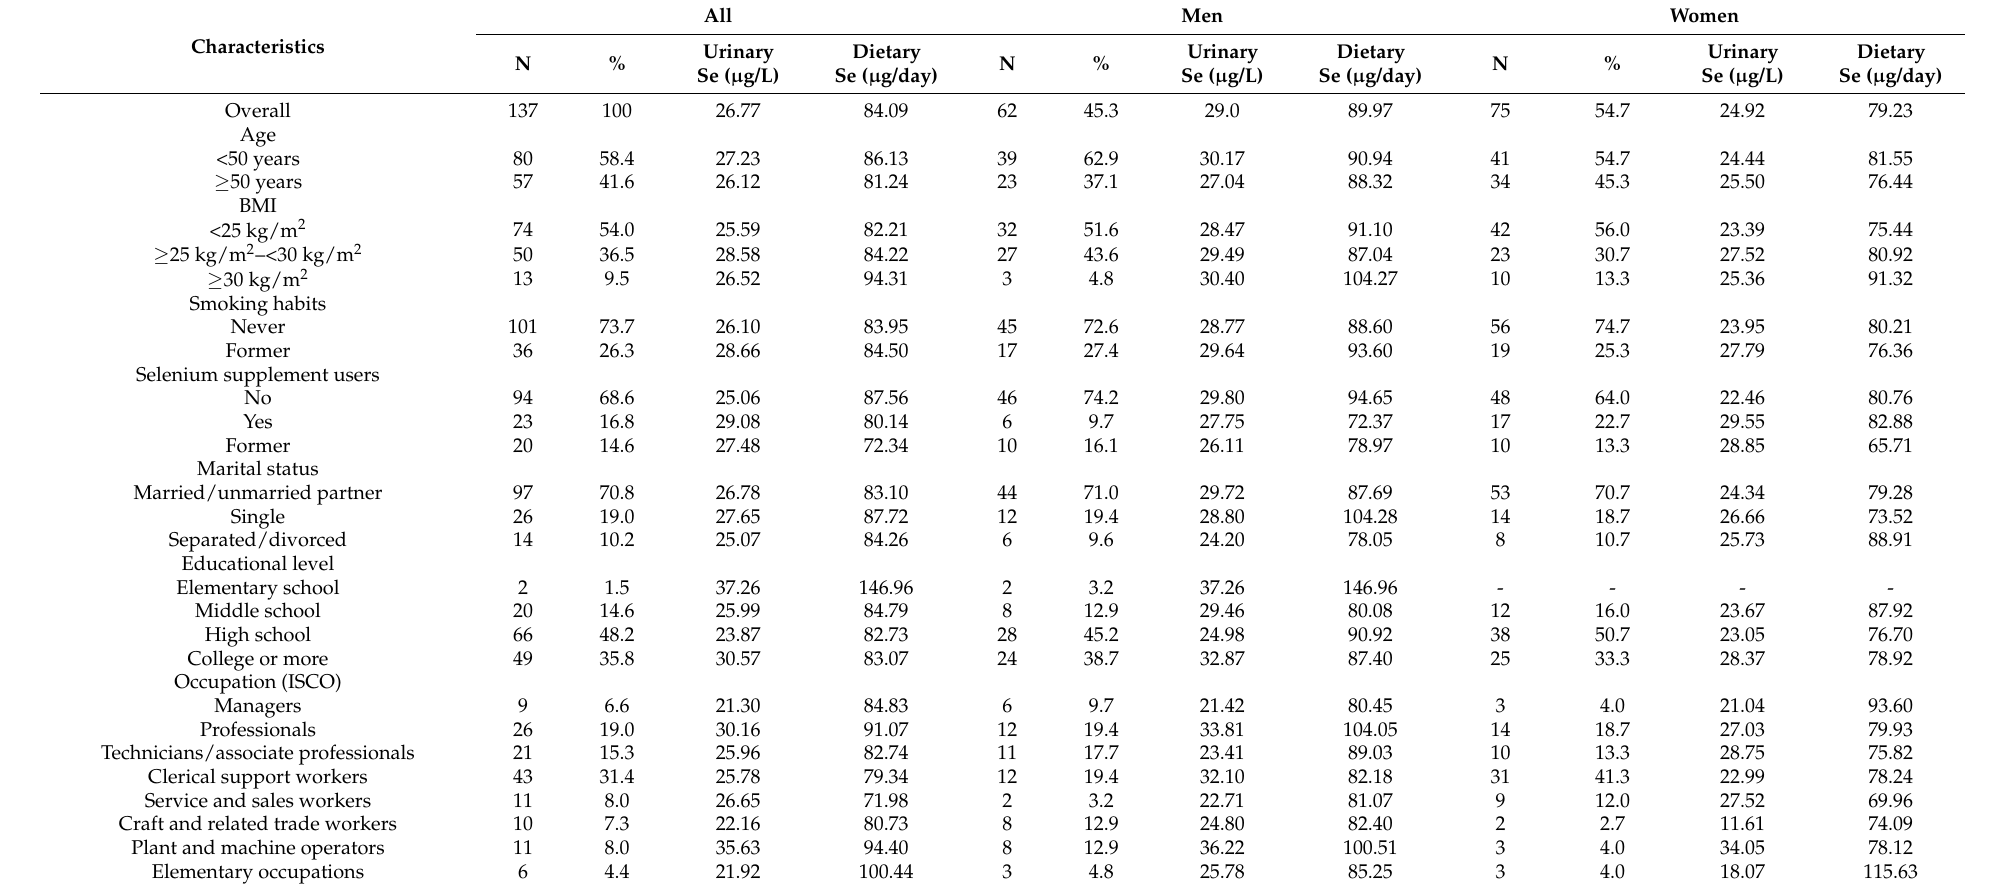
Table 1. Characteristics of the study population and mean urinary and dietary selenium (Se) concentrations for each